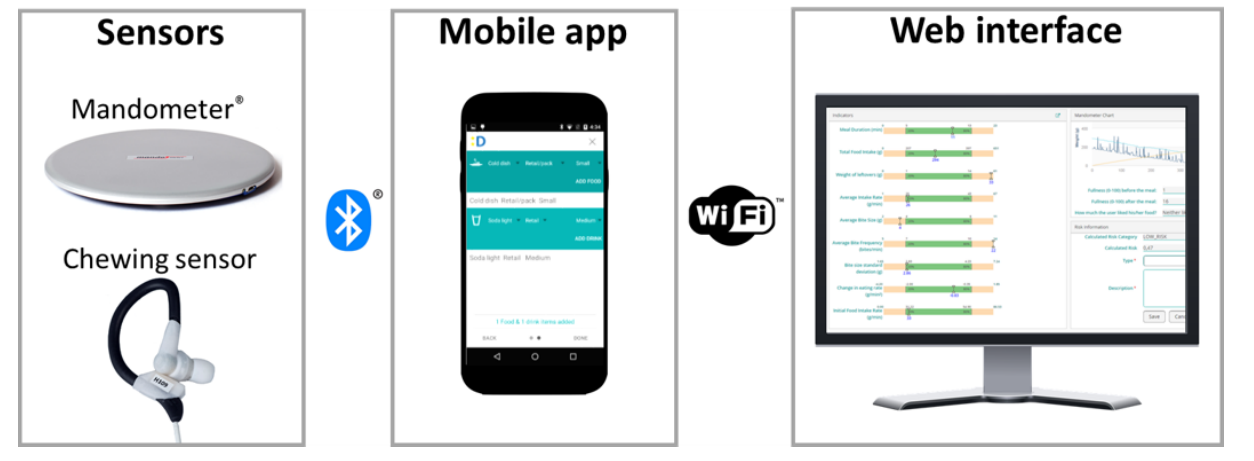
Figure 2. Main screen of the smartphone